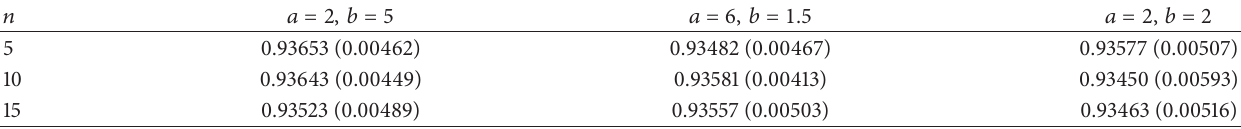
Table 2: Average empirical confidence level (1 − 𝛼) for 𝐶 𝐿 under MLE when 𝛼 = 0.05 .